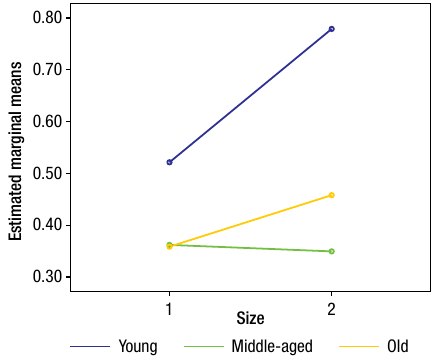
Fig. 8. EBITDA’s VAR COEFF